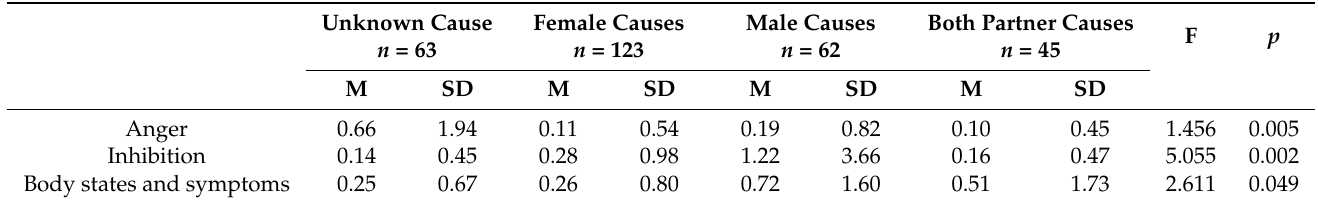
Table 4. Significant differences in linguistic dimensions between groups of women who undergo ART treatments for different infertility